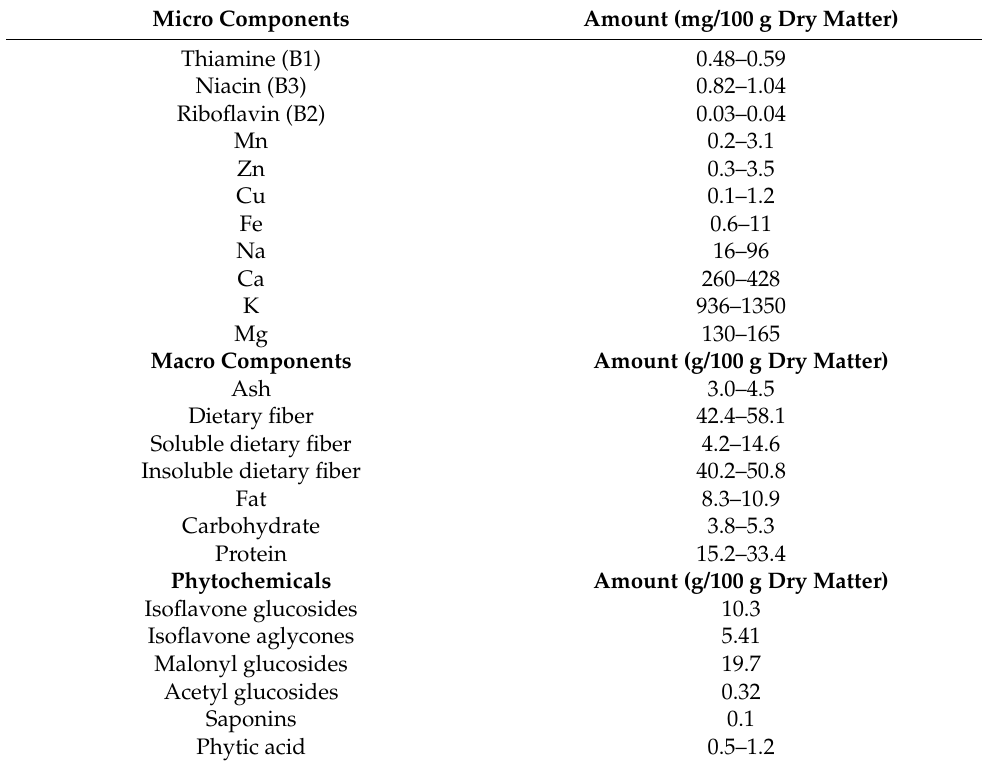
Table 2. General nutritional constituents of soybean residue